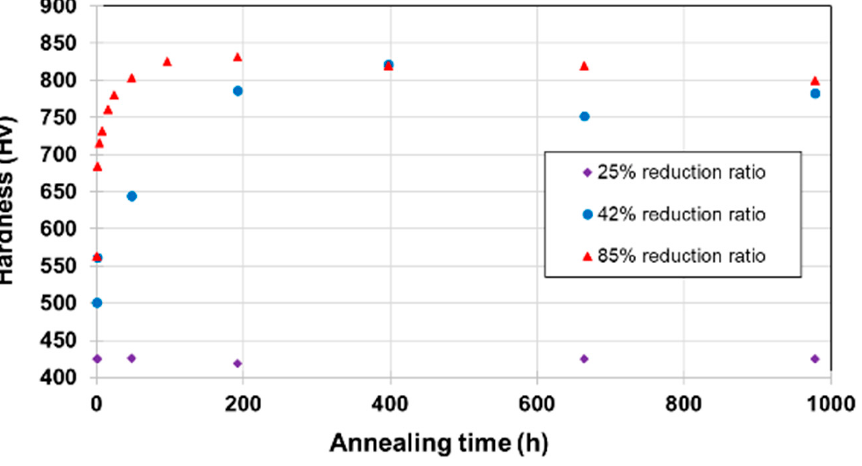
Figure 4. Evolution of mean microhardness with annealing times when annealed at T = 575 °C. Error bar is smaller or about marker size.